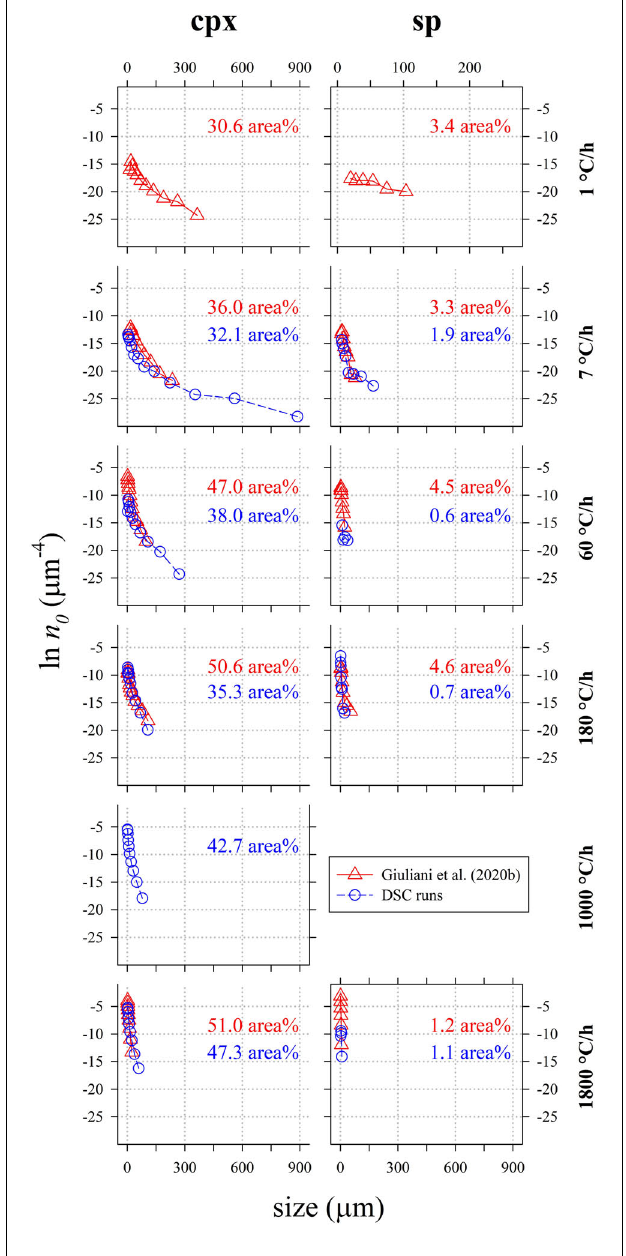
FIGURE 7 | Crystal size distribution (CSD) of cpx computed by CSD Corrections (Higgins, 2000) and relative crystal content (area%). Data are listed in Tables 4 , 5